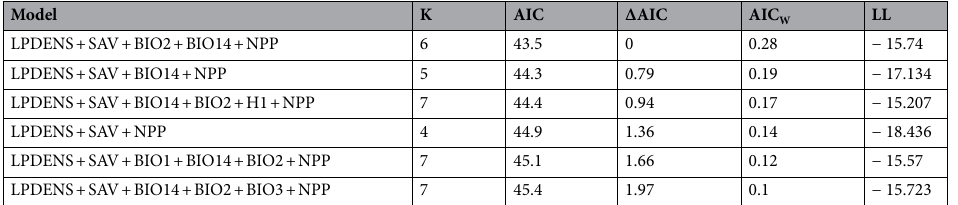
Table 2. Model comparisons of the best logistic regression models (ΔAIC ≤ 2.0) for assessing N-tiger cat occurrence in the Amazon biome. *AIC = Akaike Information Criterion. *∆AIC = Change in AIC units with respect to the most parsimonious model. *AIC W = AIC weight. *LL = Log-likelihood. LPDENS = log- transformed ocelot density; SAV = savanna; BIO2 = mean diurnal range; BIO14 = precipitation of driest month; NPP = net primary production; H1 = canopy height; BIO3 = isothermality.